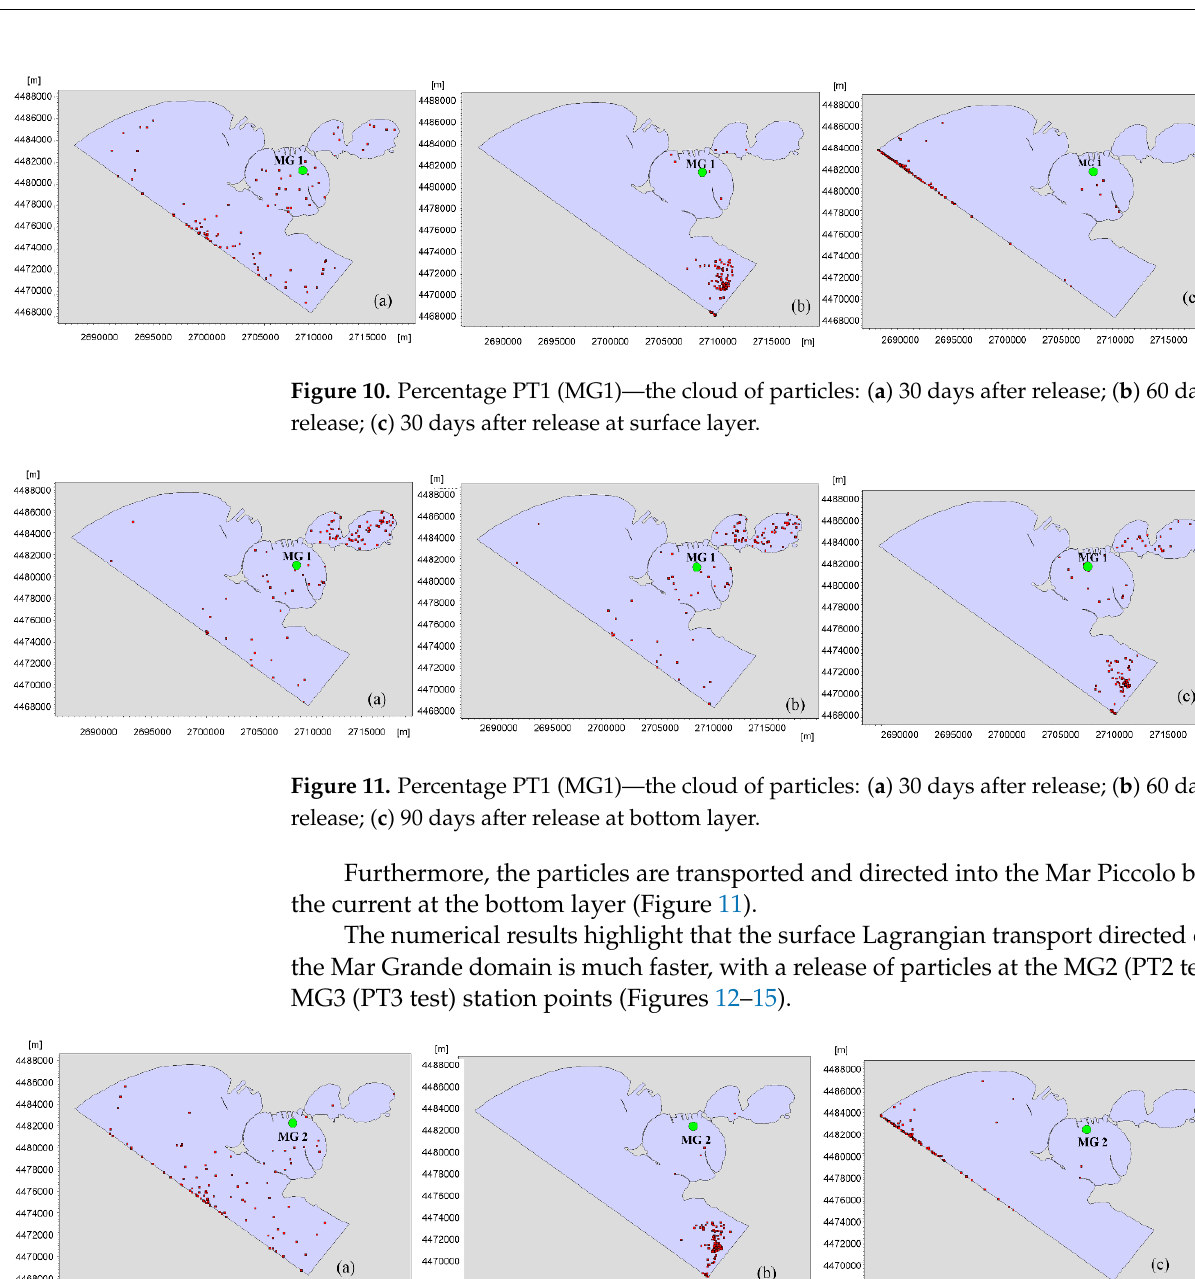
Figure 12. Percentage PT2 (MG2) — the cloud of particles: ( a ) 30 days after release; ( b ) 60 days after release; ( c ) 90 days after release at surface layer.